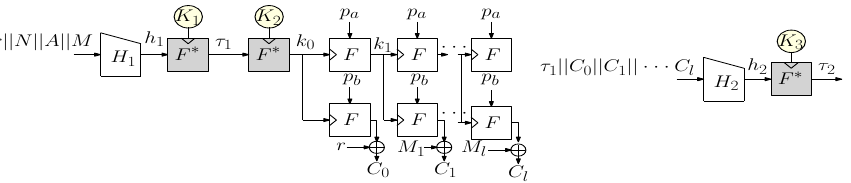
Figure 3: The MEM construction. F ∗ denotes the frPRF s realized with fault-free